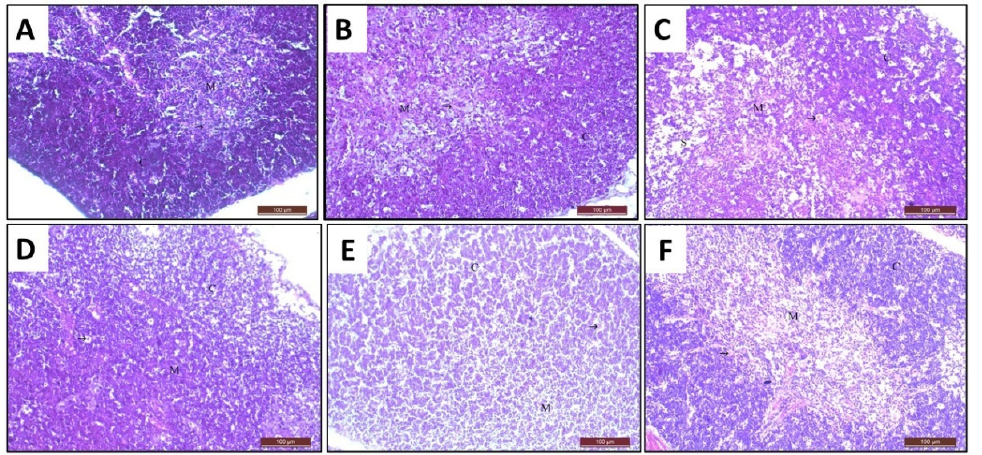
Figure 9. Photomicrographs of section of the thymus stained with H&E × 200 from different groups. ( A ) : (control group) shows normal histologic structure of the cortex (C), medulla (M), and Hassal’s corpuscles ( → ). There is an increased density of the lymphocytes in the cortex. ( B ): (OLE group) is similar to control group. ( C ): (Cis group) shows marked decrease in lymphocytes density in the cortex (C) and medulla (M). Also, there is an increase in Hassal’s corpuscles ( → ) in the medulla. There are empty spaces in the medulla (S). ( D ): (Cis + OLE group) shows restoration of normal histological structure of the thymus but less than Cis + MSC group. In addition, there are Hassal’s corpuscles ( → ). ( E ): (Cis + CM-MSC group) shows decreased lymphocytes density in the cortex (C) and medulla (M), but it is more similar to Cis + MSC group ( F ): (Cis + MSC group) shows restoration of normal histological structure of the thymus, but there is mild decreased lymphocyte density in the cortex (C) and medulla (M). In addition, there are Hassal’s corpuscles ( → ).